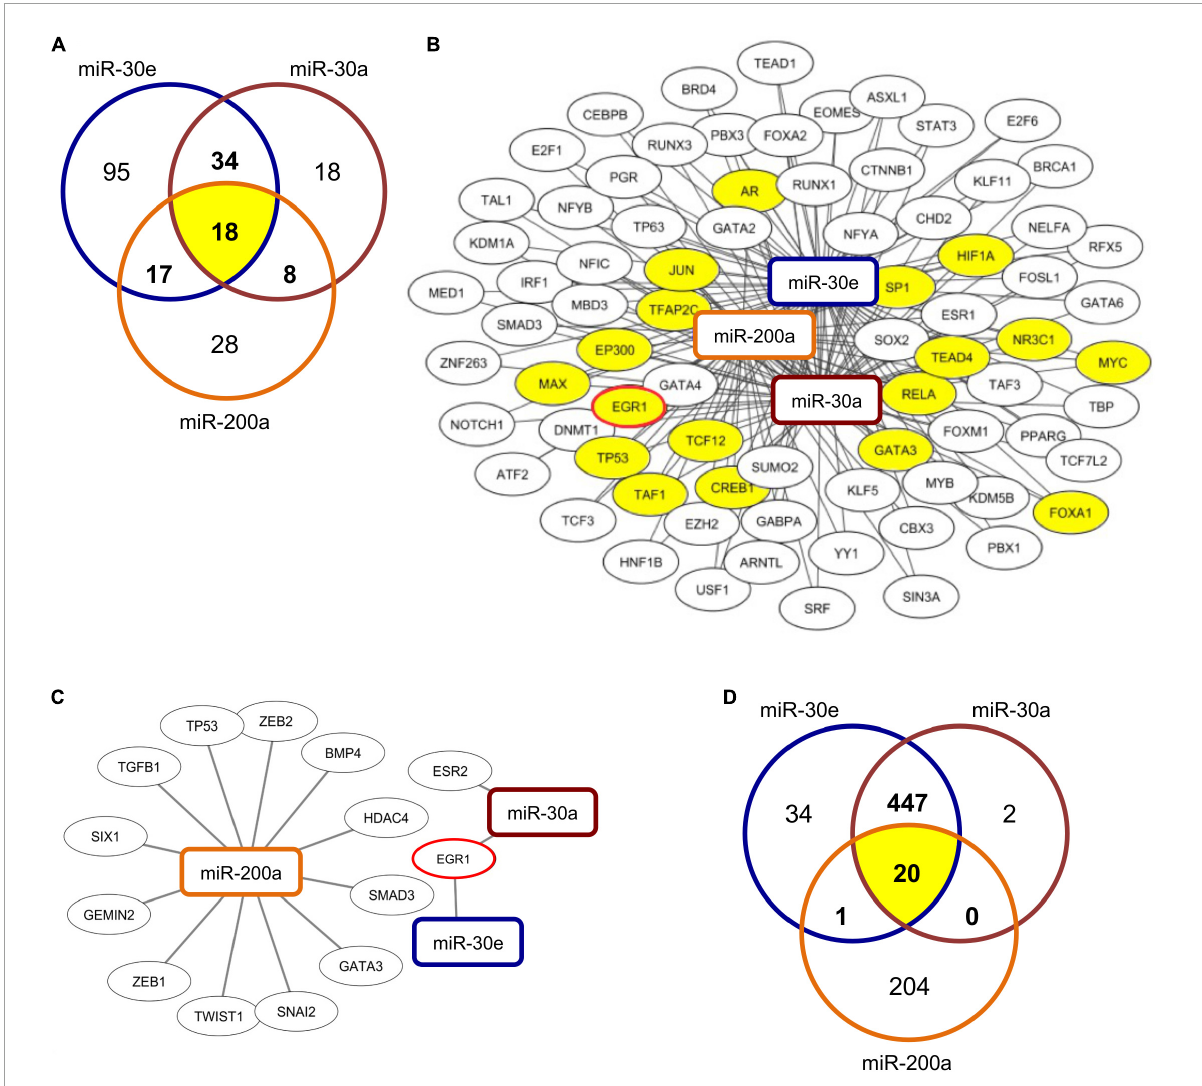
FIGURE2 Prediction of TF-miRNA binding and of potential miRNA targets. (A) Venn diagram depicts number of predicted transcription factors (TF) that are able to interact with the respective miRNAs and their overlap and (B) shows network of TF-miRNA interactions of 77 TFs predicted to interact with at least two of the three assessed miRNAs. Visualization was carried out using the Cytoscape software with the respective miRNAs predicted by TransmiR database. The 18 common TFs predicted to interact with all three miRNAs are highlighted in yellow. (C) Network of predicted TF-miRNA interactions from RegNetwork database analysis. 14 TFs were predicted to interact with at least one of the assessed miRNAs. Visualization was carried out by use of the Cytoscape software. (D) Venn diagram depicts number of predicted targets of respective miRNAs and their